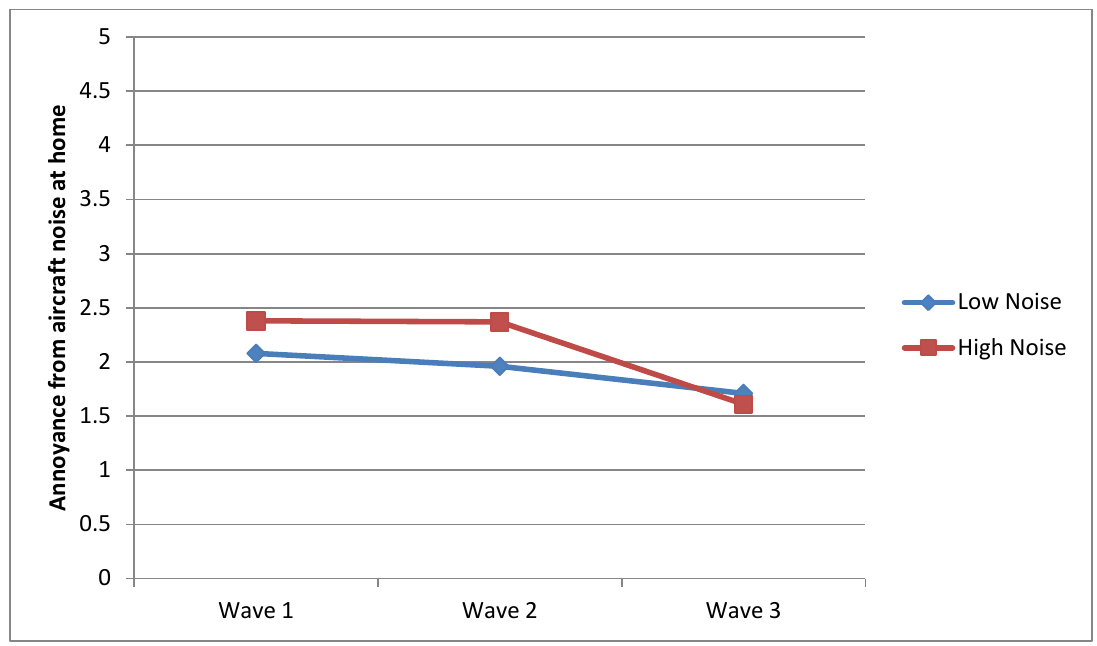
Figure 6. Annoyance reactions from aircraft noise at